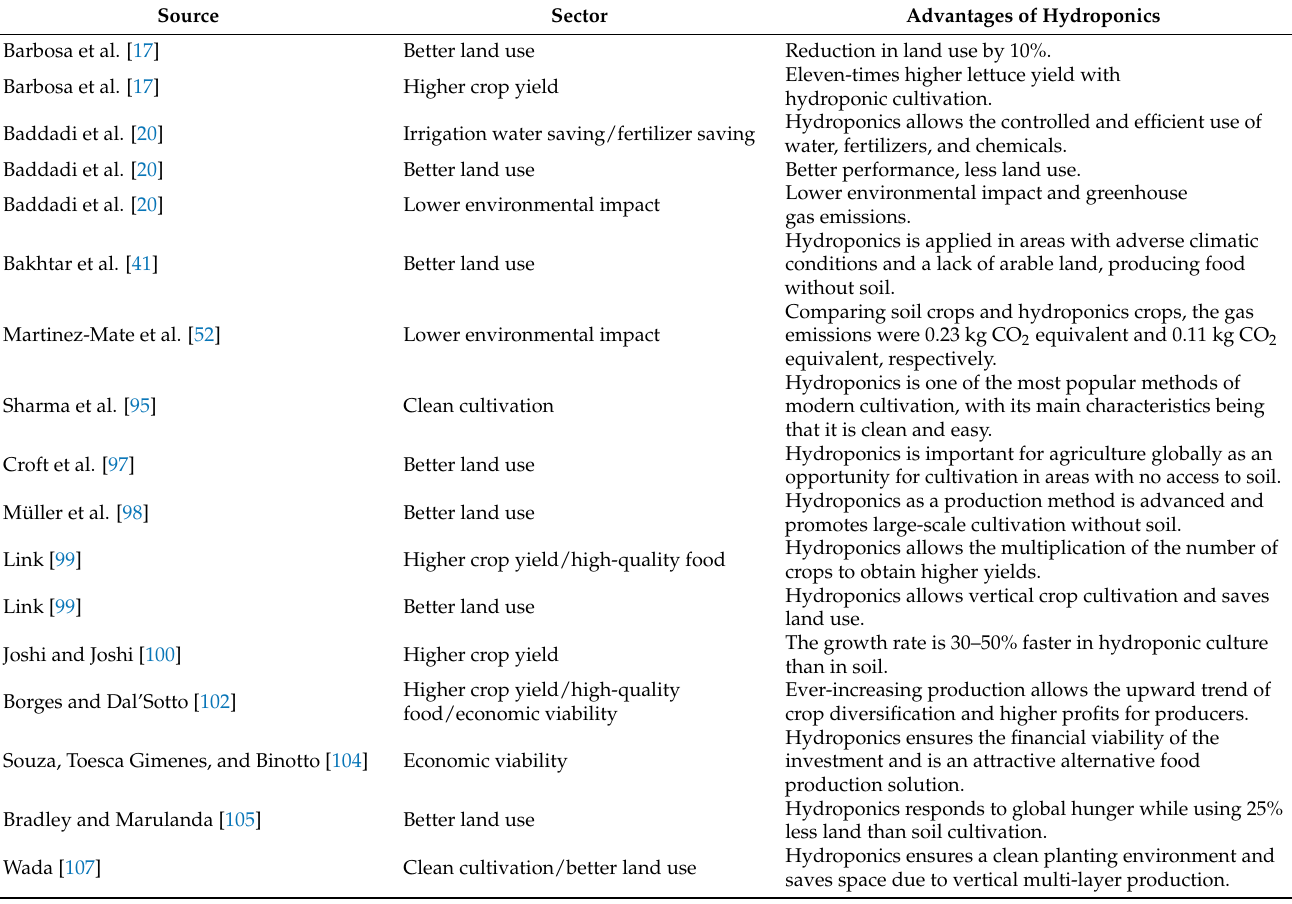
Table 5. Advantages of hydroponic